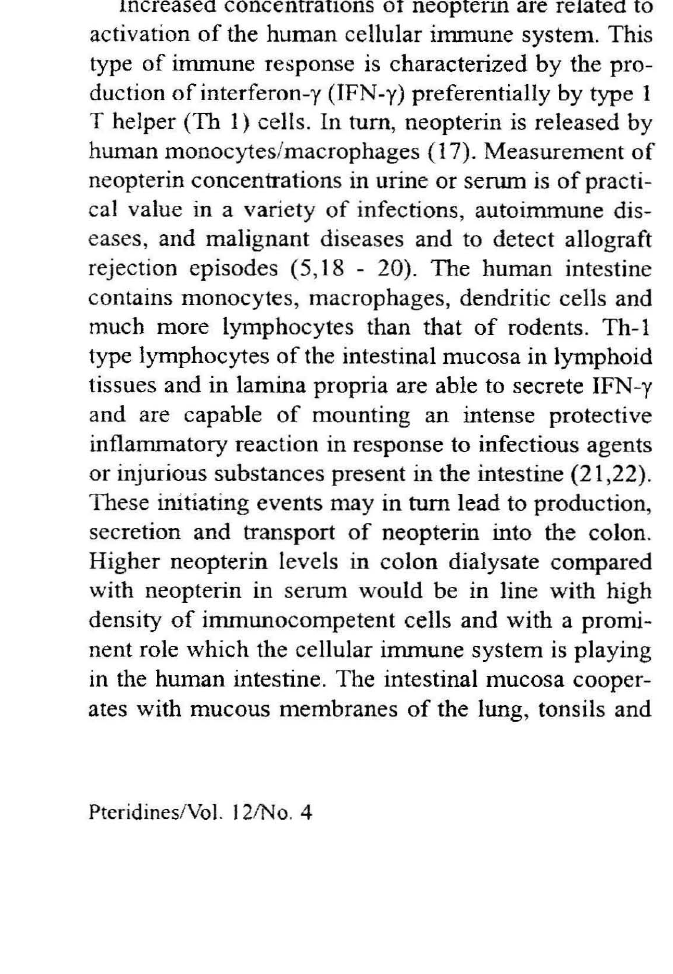
Figure 3. Concentrations of urinary neopterin (/lmolimol creatinine; mean ± S.D.) in healthy indi viduals and healthy individuals during starvation diet (** p < 0.05, when compared with controls) colon dialysates were measured in healthy individuals and the results were compared with simultaneously determined salivary and urinary neopterin levels. The neopterin concentrations of healthy subjects were about ten times higher compared to concentrations in serum or saliva. Common diseases were associated with a strong increase of the neopterin concentrations in the colon dialysate. During the starvation diet neopterin concentrations in dialysates were lower than those of the control